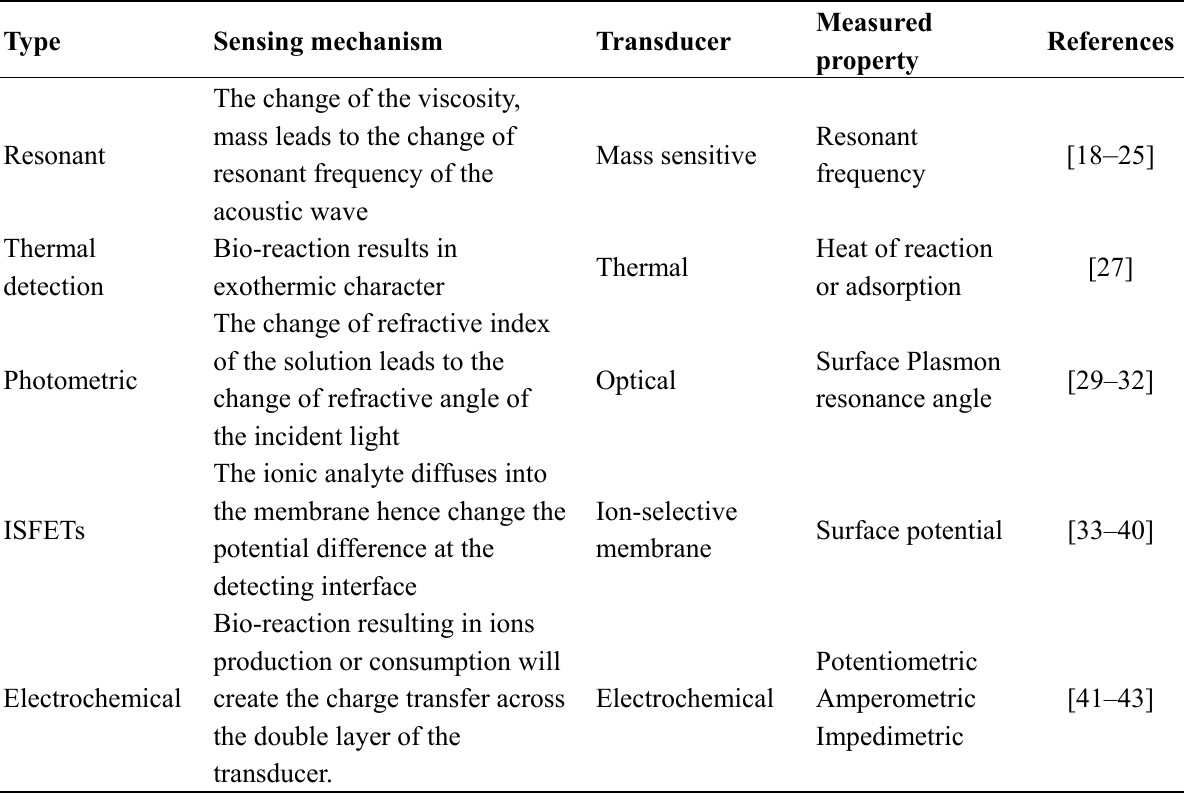
Table 1. Summary of